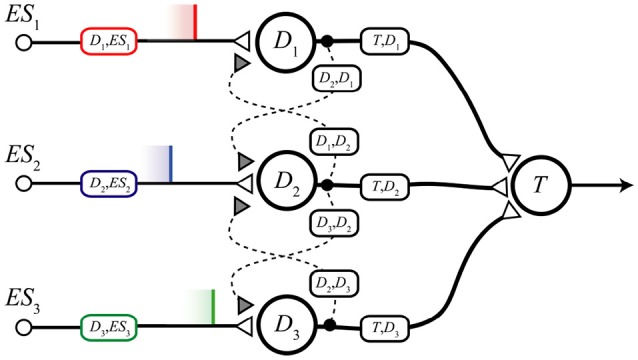
Scheme of the presented structure. The three delay branches, characterized by the three delay neurons D1, D2, D3, converge to the target neuron T. Heterosynaptic STDP interactions are permitted by lateral connections, represented as dotted curves with related synapses.